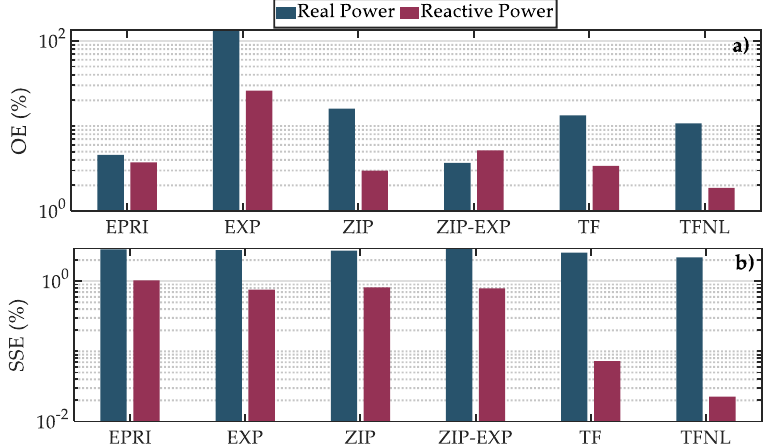
Figure 15. ( a ) Overshoot and ( b ) steady-state percentage relative errors. Note that the results are illustrated using a logarithmic scale.